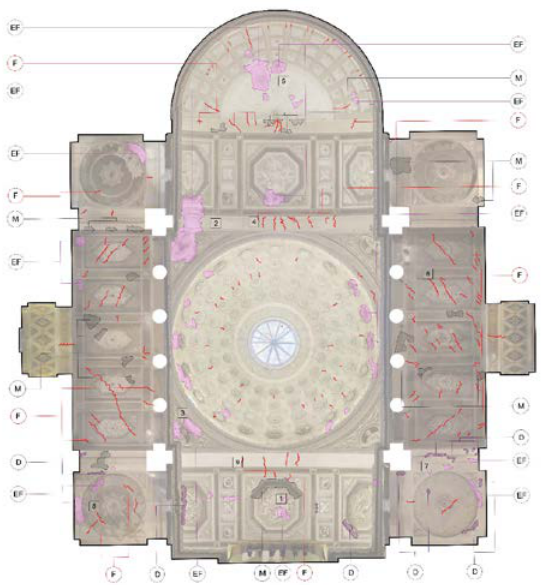
Figure 10. Hyposcopic view of the ceiling with the projection of the vaults and the domes: cracking pattern and decay mapping.